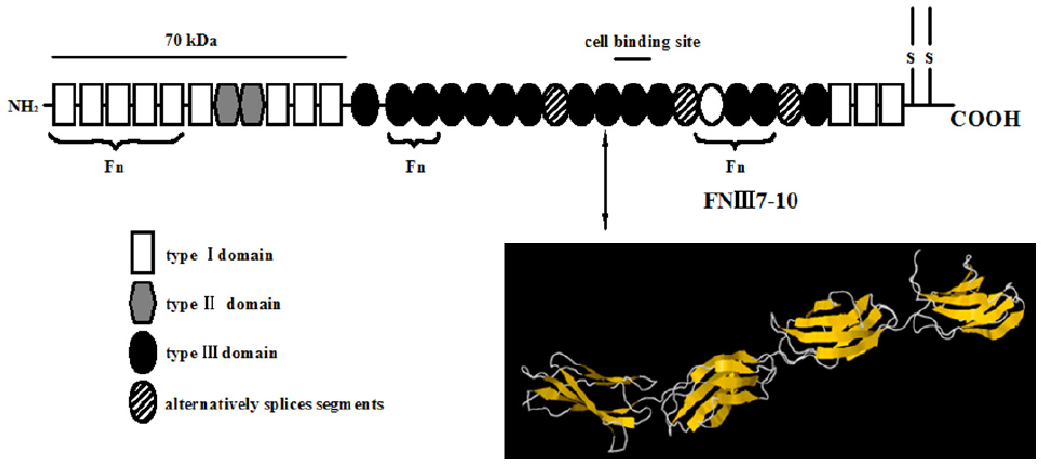
Figure 6. Schematic representation of fibronectin modules and structures [20]. Fibronectin is a 450–500 kd dimeric protein composed of more than 20 modules per monomer. Two monomeric strands linked by two disulfide bridges and each monomer contains three types of modules, types I–III, and/or alternatively splices of segments that are found inserted or found missing in various spliced forms of fibronectin. Arrow specified the 7–10th type III module of fibronectin (FN-III7-10), which contains cell recognition site.